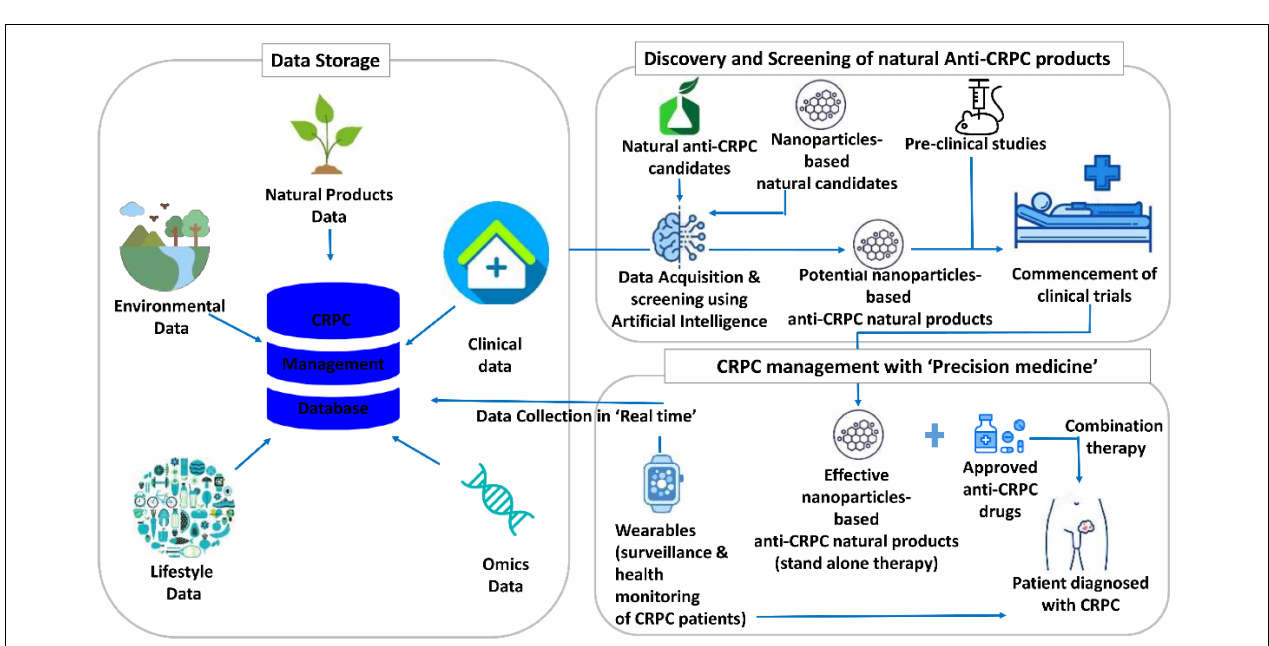
FIGURE 4 | Application of quercetin nanomicelles in providing targeted delivery in prostate cancer therapy. These nanomicelles promote the penetration of quercetin into cancer cells, leading to an increase in bioavailability and subsequent enhancement.